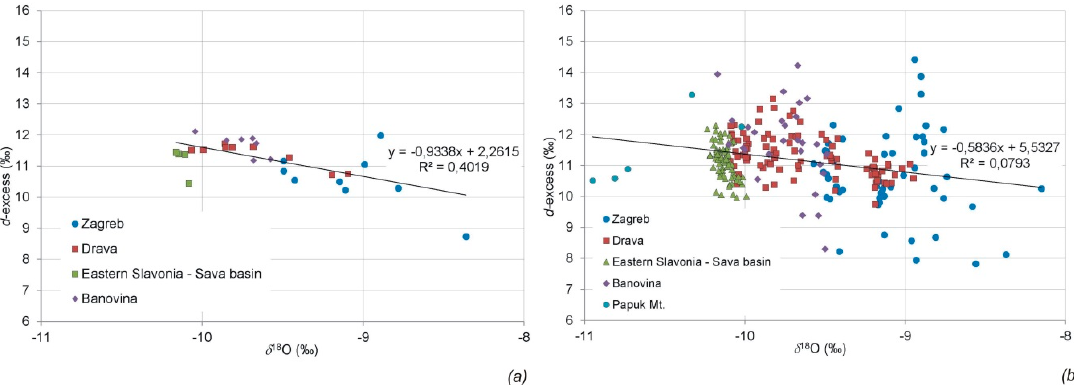
Figure 8. Relationship between δ 18 O and d -excess in the analysed groundwater in the Pannonian part of Croatia: ( a ) the mean values and ( b ) the single values. 464